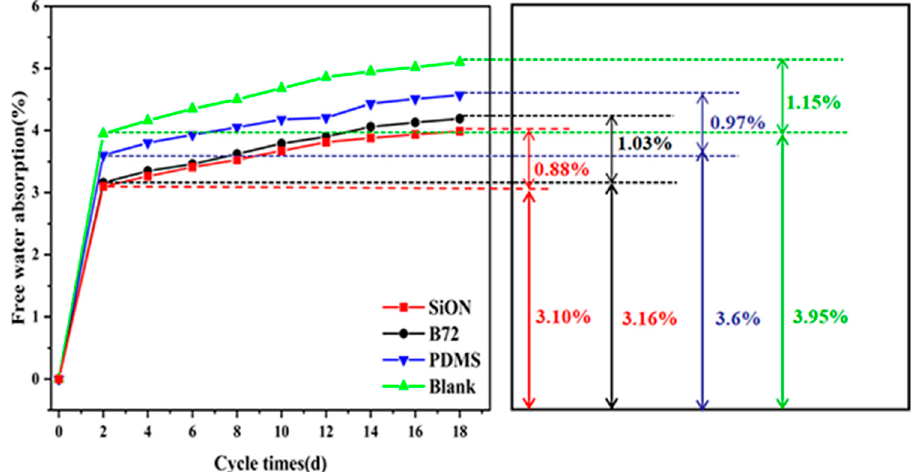
Figure 6. Free water absorption of sandstone before and after coating with different